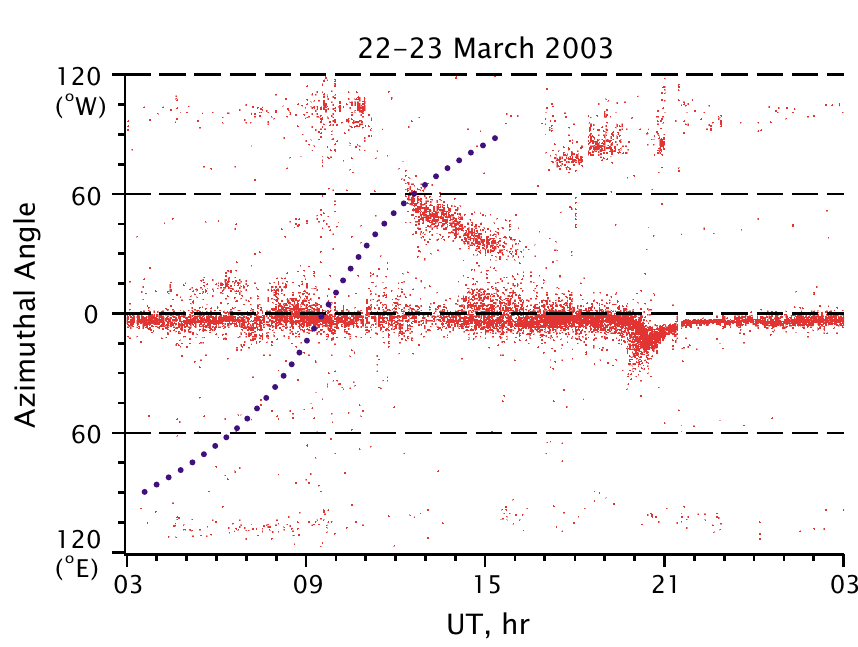
Fig. 4. The same as for Fig. 3, but for 22–23 March 2003. The dotted curve means a constant local time condition at the reflection point.